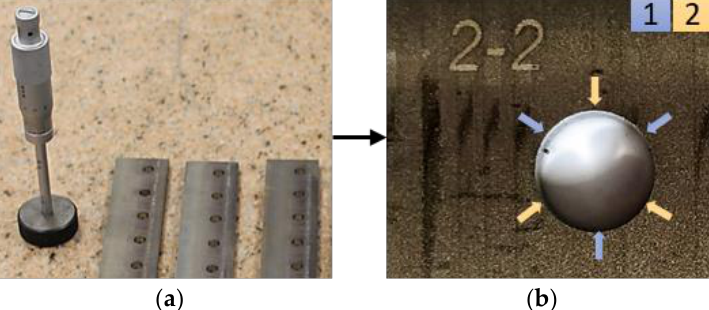
Figure 6. ( a ) Evaluation with micrometre of three contacts. ( b ) Diameter evaluation positions.